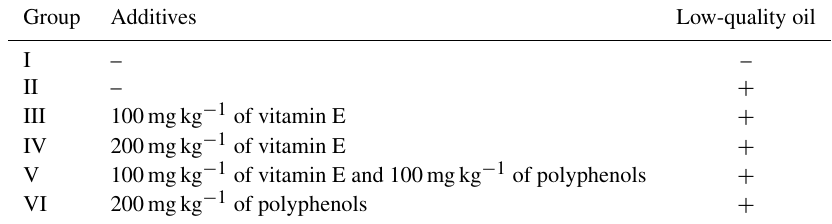
Group Additives